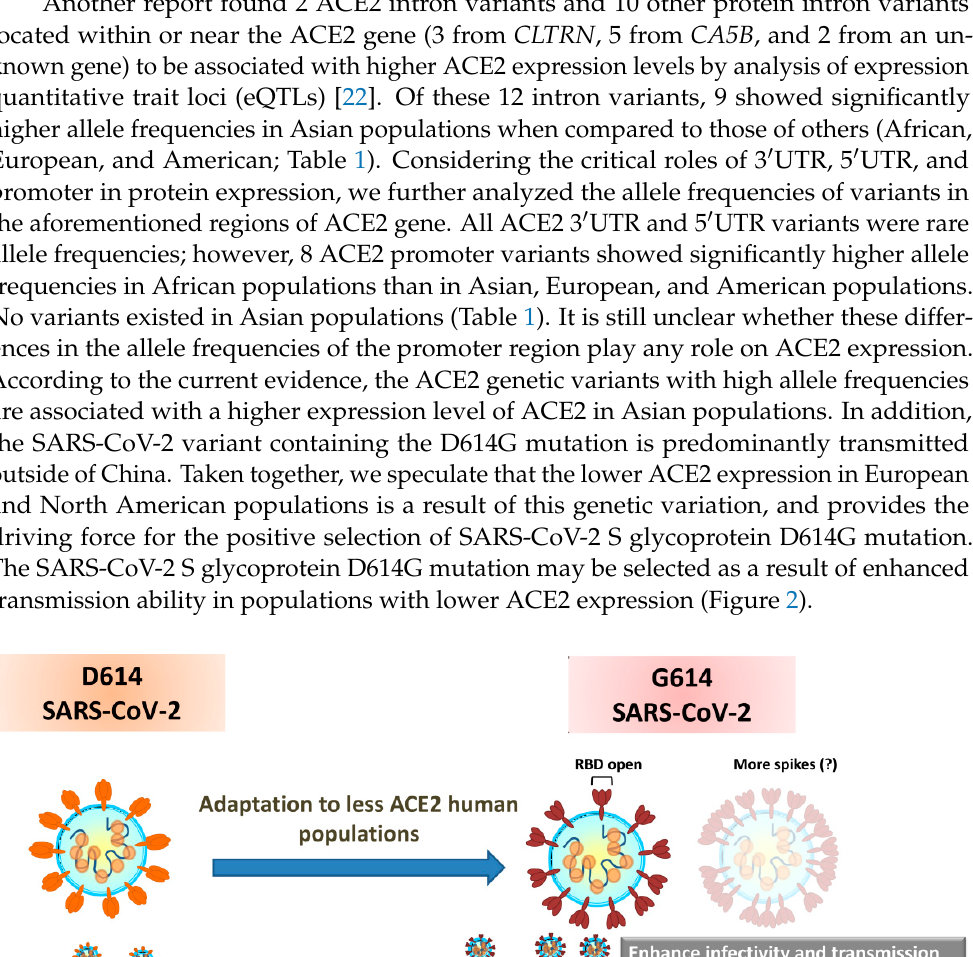
Figure 1. Transition of severe acute respiratory syndrome coronavirus 2 (SARS-CoV-2) spike (S) glycoprotein D614 to G614 variant in different geographic regions. ( A ) Weekly ratio of D614 and G614 variants globally, and in China, Europe, North America, South Asia, and Africa. Data analyzed from COVID-19 Viral Genome Analysis Pipeline (https://cov.lanl.gov/). ( B ) Angiotensin 1-converting enzyme 2 (ACE2) expression level in different geographical regions. ACE2 expression score analyzed by 21 ACE2 genetic polymorphisms that significantly affect its expression level according to the current study [18]. ( C ) Pearson’s correlation coefficient (r) and p value between ACE2 expression score and preva- lence of D614 variants in different geographical regions.